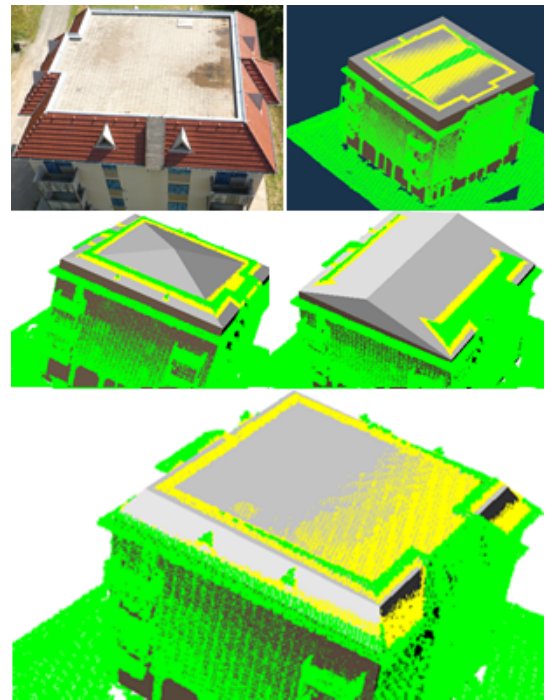
Figure 5: MMSE fit for flat, pinnacle, gable and mansard roof types on a mansard roofed building data set obtained from im- age matching. The yellow points are the inliers to the “best” 3D polygonal chain. As expected, the mansard roof model explains the data best by providing the best fit.